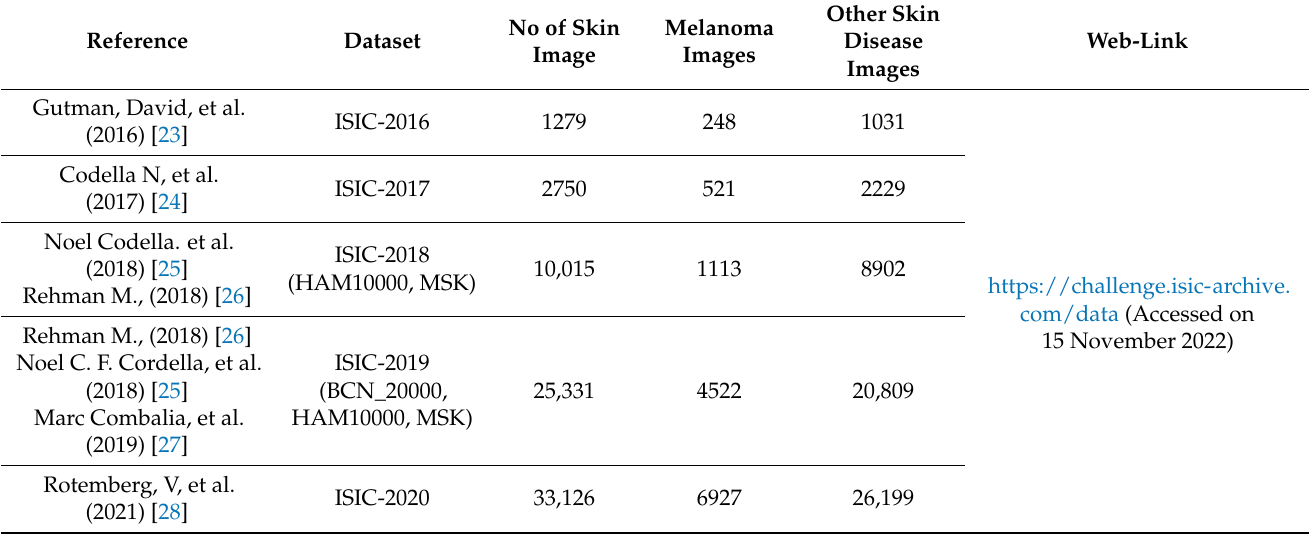
Table 2. Skin Image